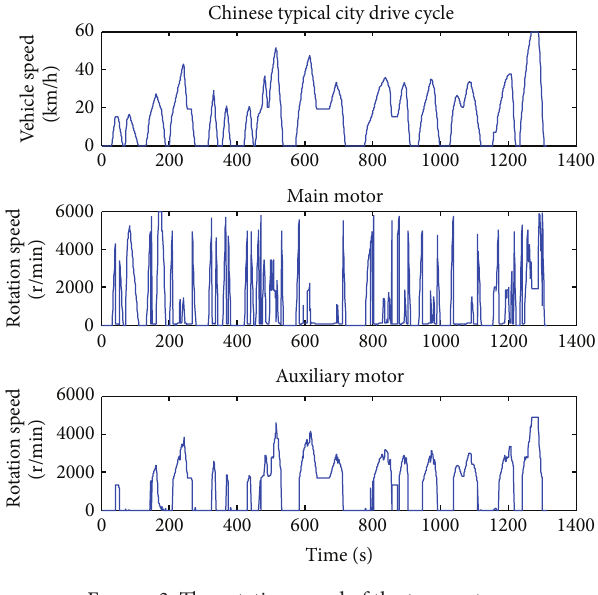
Figure 3: The rotating speed of the two motors.